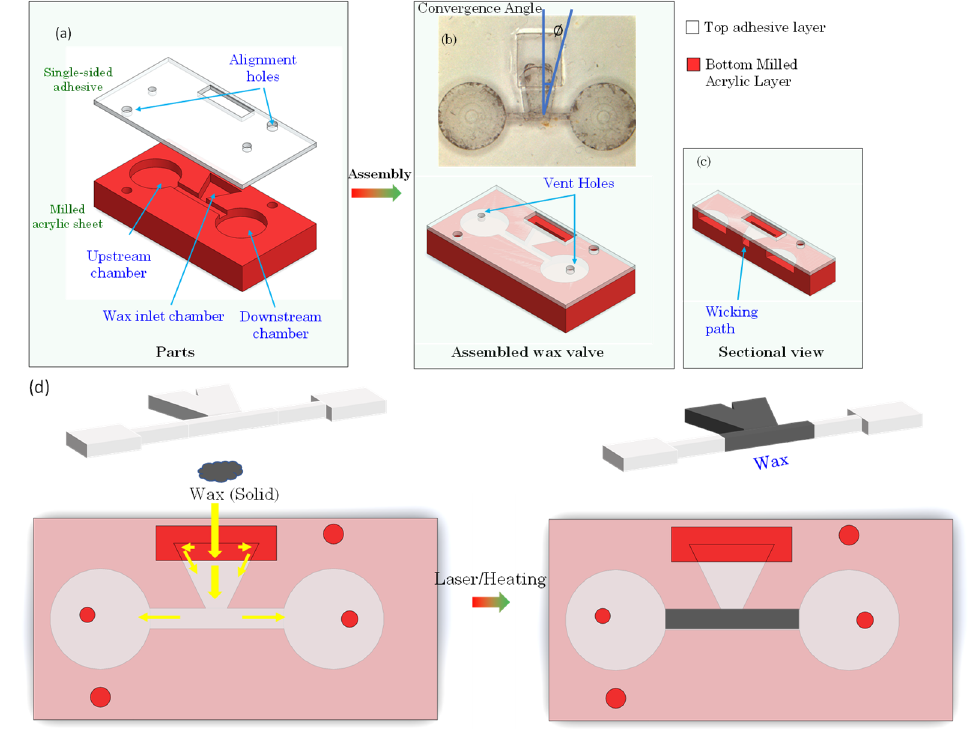
Figure 3. ( a ) Layers of the wax valve: the top layer of this assembly consists of a single-sided adhesive sheet that contains the openings for vent holes, alignment holes, and openings for loading the wax in the wax chamber; the bottom layer is an acrylic layer machined, according to the valve 3-D model, to provide for the upstream chamber, the wax inlet chamber, the fluidic channel, and the downstream chamber. ( b ) The layers are pressed together using a roller (Akiro, B07YDNKSH6) to activate the pressure-sensitive adhesive that binds the layers together. Top diagram also defines the valve convergence angle, which is the angle between the perpendicular to the valving channel and the inclined side of the wax chamber. ( c ) Cross-sectional view of the valve showing the wicking path of the wax. ( d ) Wax is deposited as a solid pellet through the opening in the adhesive layer (left). After heating, the molten wax under the influence of capillary force (yellow arrows) flows into the fluidic channel and blocks the fluidic path (right). Red circles and rectangles indicate the openings in the top layer. Larger red circles denote the alignment holes.